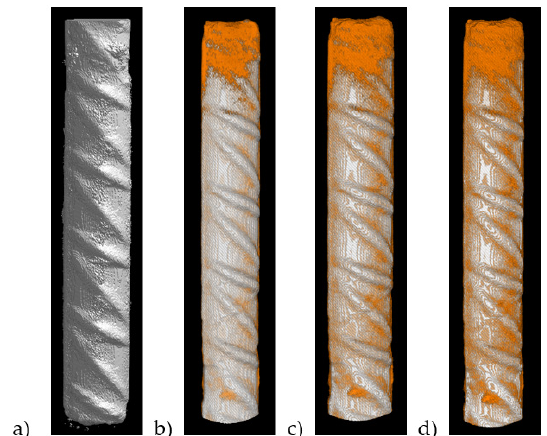
Figure 7. The 3D X-ray micro-CT visualization of steel rebar: ( a ) before corrosion acceleration experiment, ( b ) 14th day of the experiment, noticeable first corrosion changes within the rebar, ( c ) 42nd day of the experiment and, ( d ) 70th day of the